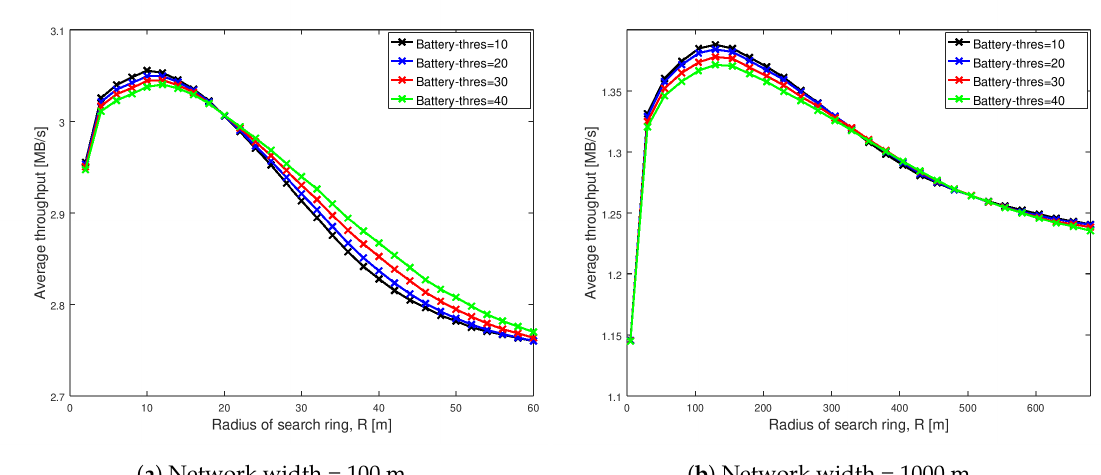
Figure 9. Average throughput of our proposed scheme MRS-ST-BL at different battery threshold when Shape = 1.01 and Scale =